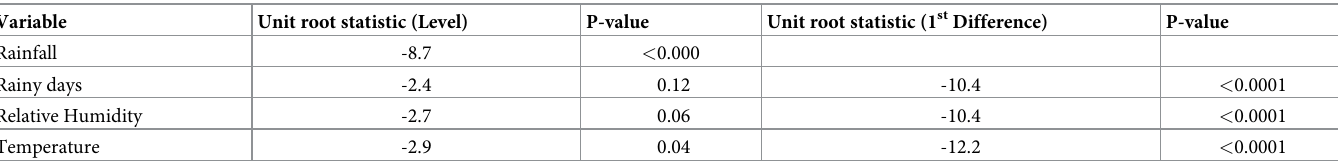
Table 4. Unit root test results of the independent variables for the multivariate